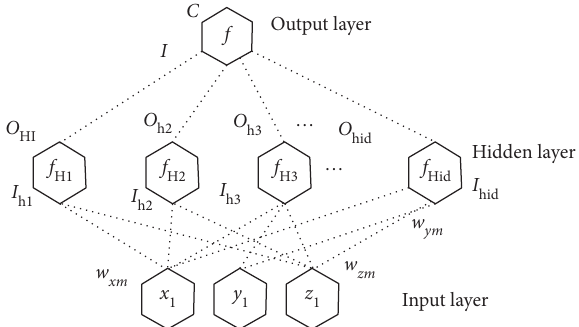
Figure 1: The neural network of the obstacle penalty layer, and an output layer. The three neurons of the input layer are the coordinates x , y, and z for a given path point. The connection weight from the hidden layer to the output layer is 1, and the threshold of the output layer neuron is a negative number minus 0.5 from the number of inequalities.